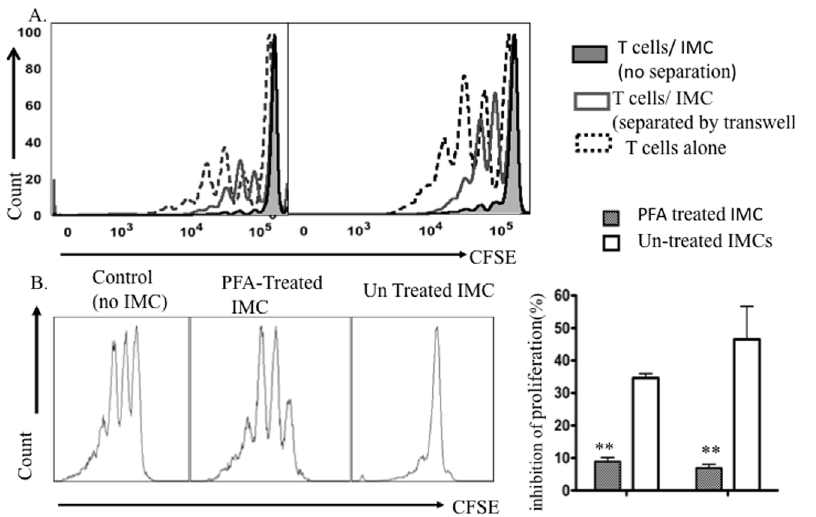
Figure 7. Viability of IMCs & cell-cell contact is required for suppression of T-cell proliferation. A) CFSE fluorescence histograms of purified T-cells activated with Dynabead cultured alone or co-cultured with sorted CD11b + GR-1 + IMCs in regular and Transwell plates at a 1:1 ratio for 4 days. Data are representative of three experiments. B) CFSE fluorescence histograms of viable CD4 + T-cells after 4 days co-culture with PFA- treated CD11b + GR-1 + IMC (middle panel); untreated IMCs (right panel) versus T-cells alone (left panel). C) Mean values 6 SD for inhibition of proliferation of CD4 + and CD8 + T-cells after culture with PFA- treated IMCs compared with untreated culture IMCs ( p , 0.001 ). Data from three individual experiments. Figure S1 IMCs inhibit activation of Dynabeads activat- ed T-cells. Freshly sorted naı¨ve BM-derived CD11b + GR-1 + cells AAD ( 2 ), Annexin V ( 2 ) T CD4 + cells after 4 days of culture. E) Flow cytometry analysis of CD11b + GR-1 + IMCs on day 4 co- cultures with T-cells. Left panel: scatter profile; Middle panel: CD11b + IMCs from co-culture; Left panel: Annexin V and 7-AAD Figure S2 IMCs inhibit Ki-67 expression in T-cells were co-cultured with anti CD3/CD28 beads. CFSE-labeled T- cells from wild type mouse spleen were co-cultured with FACS sorted BM-derived CD11b + GR-1 + IMCs at a ratio 1:1. T-cells in the cultures were stimulated with anti-CD3/CD28 beads and IL-2 for 4 days. A) The CFSE profile of CD4 + T after intracellular Ki- cultured with naı¨ve BM-derived sorted CD11b + GR-1 + IMCs. B)